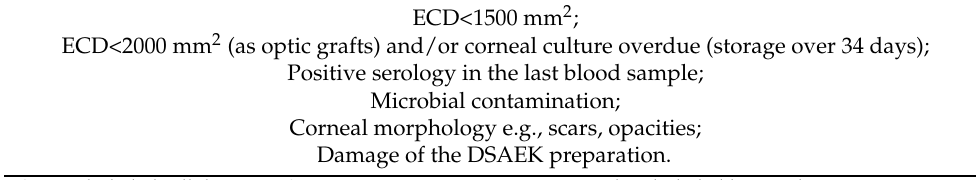
Table 2. Exclusion criteria for corneal donor grafts of the Eye Bank of Rhineland-Palatinate Mainz, assessed after explantation. ECD<1500 mm 2 ; ECD<2000 mm 2 (as optic grafts) and/or corneal culture overdue (storage over 34 days); Positive serology in the last blood sample; Microbial contamination; Corneal morphology e.g., scars, opacities; Damage of the DSAEK